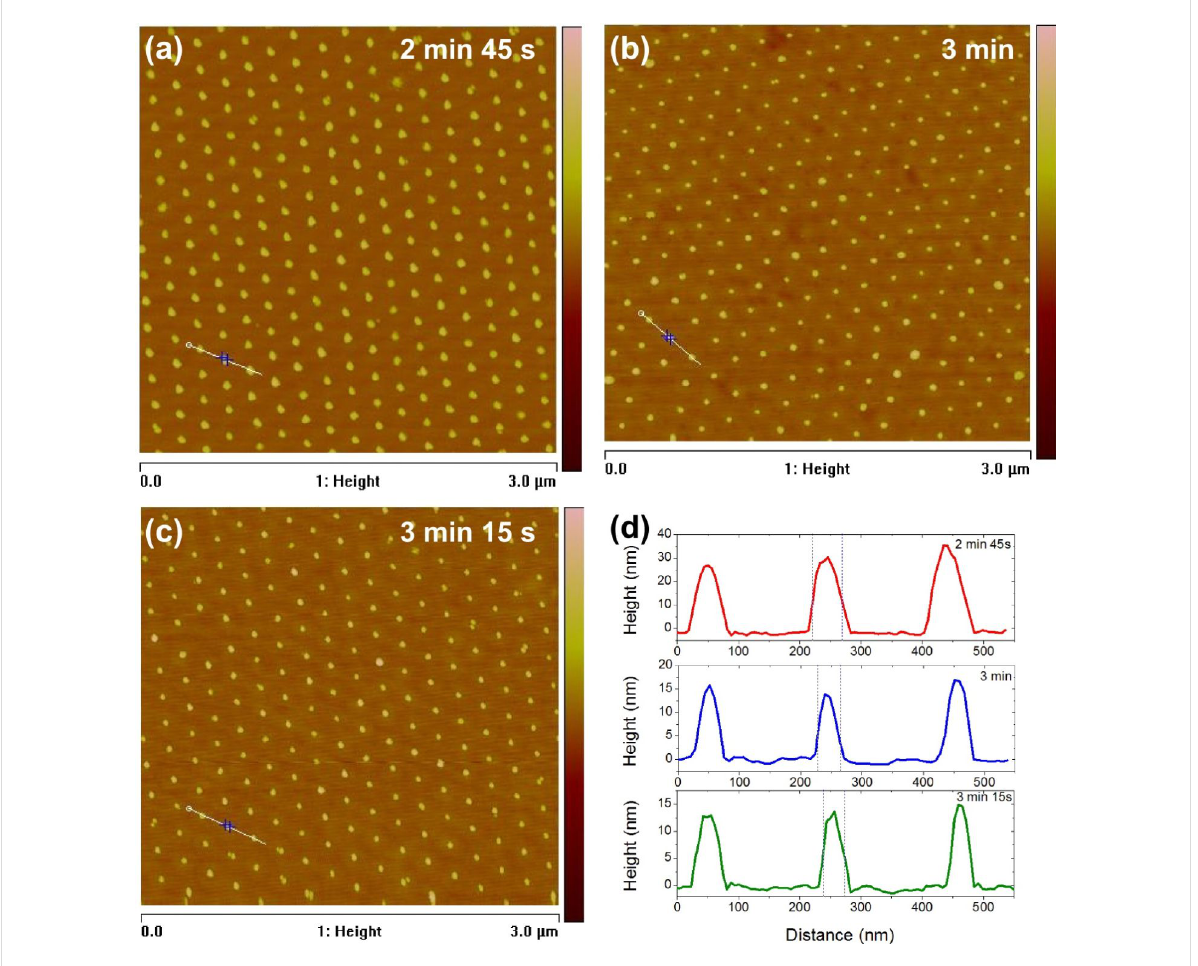
Figure 3: Polystyrene nanoparticles monolayer after plasma-ICP etching for (a) 165, (b) 180, and (c) 195 seconds. (d) AFM height profiles of the three samples shown in (a–c): raw data, without deconvolution.